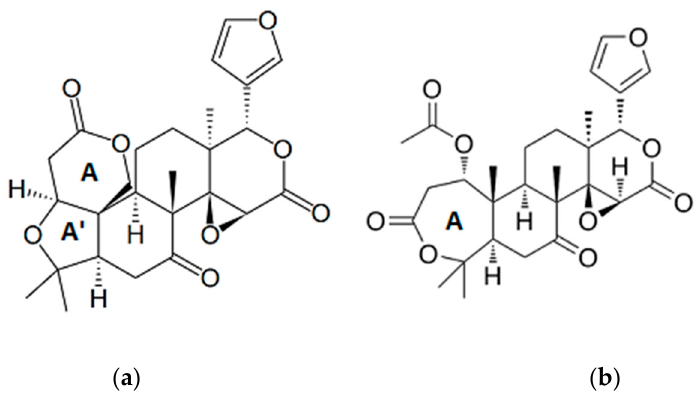
Figure 6. Chemical structure of ( a ) limonin and ( b ) nomilin, the major bioactive limonoids found in Citrus seeds.